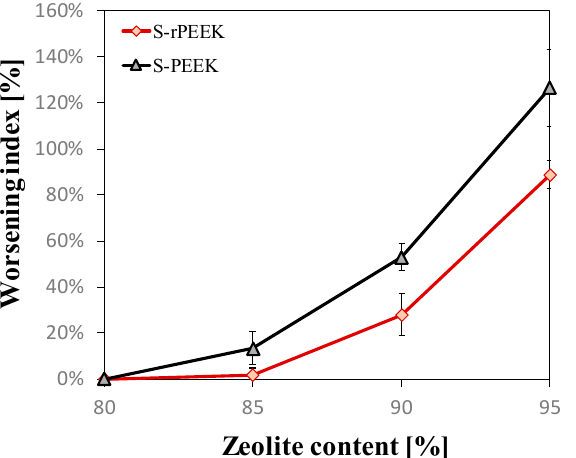
Figure 4. Worsening of scratch resistance properties compared to those obtained from coatings containing 80% zeolite at varying zeolite content for S-PEEK and S-rPEEK.